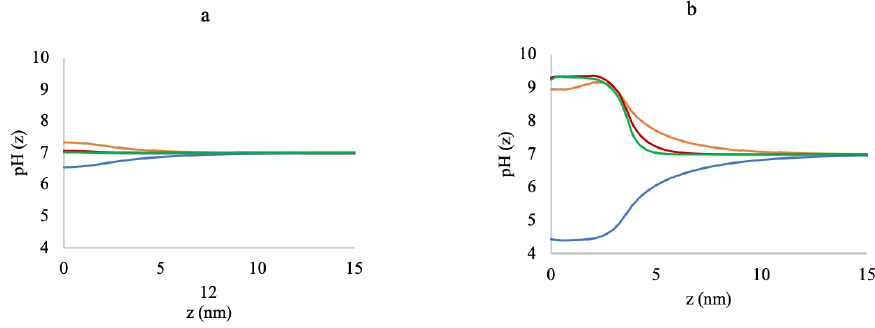
Figure 6. pH profiles along the distance from the grafting surface at ( a ) 0.005 chains/nm 2 and ( b ) 0.5 chains/nm 2 for 0 mM (blue lines), 3 mM (yellow lines), 50 mM (red lines), and 180 mM (green lines) MgCl 2